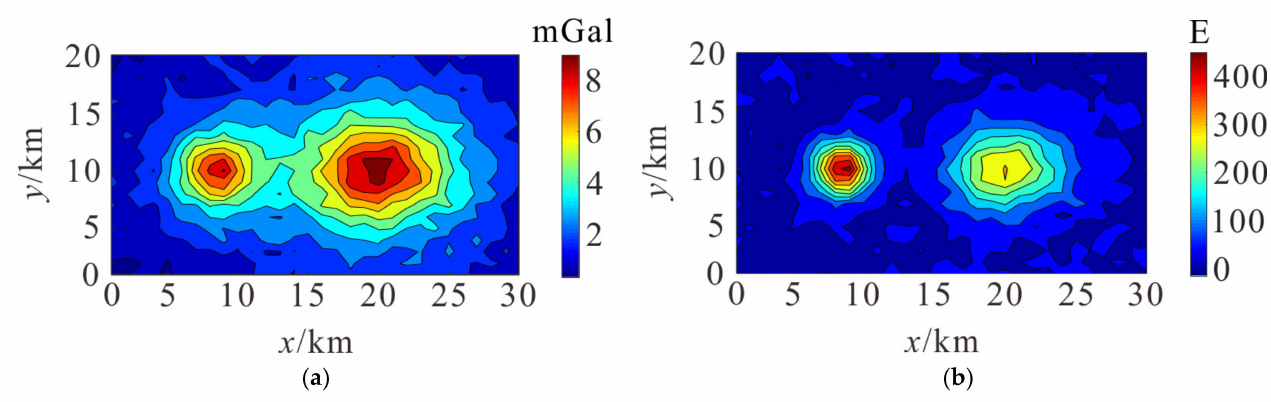
Figure 4. Information of models in different depths with 5% Gaussian noise. ( a ) Airborne gravity anomaly at 100 m altitude. ( b ) Vertical gradient anomaly of airborne gravity at 100 m